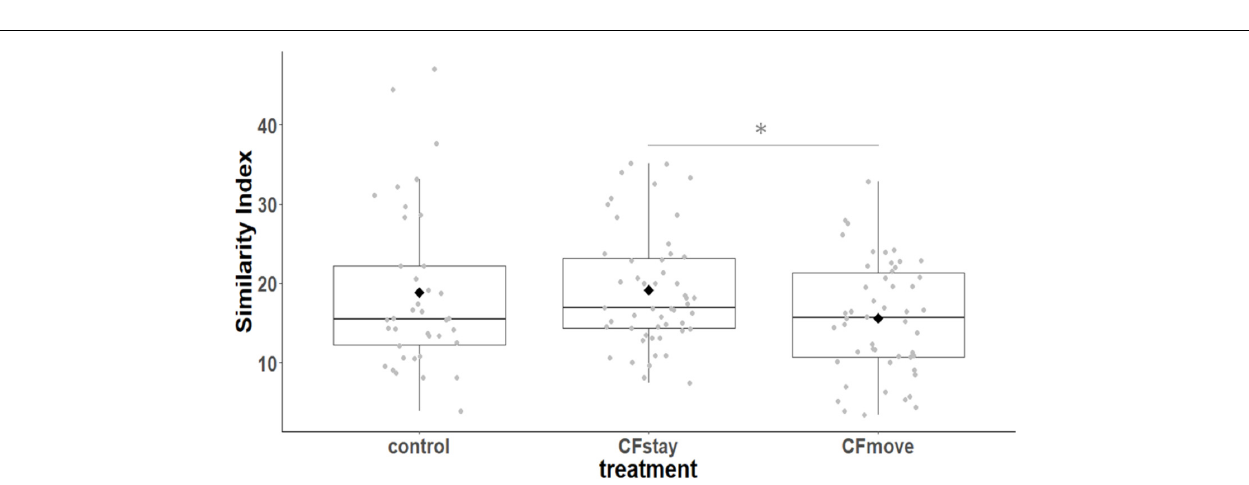
FIGURE 3 | Mean proportion (%) and the difference in the mean proportion (%) of predicted and significantly different (Welch’s t -test, Benjamini–Hochberg; q < 0.05) KEGG2 metabolic functional inferences of nestling cloacal microbiota at D8 (yellow) and D15 (blue).